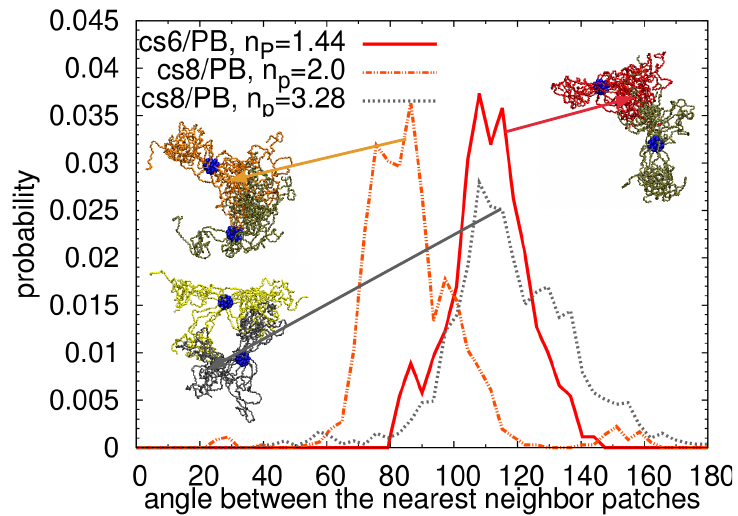
Figure 11. The probability distribution function of the intermolecular angles between the nearest neighbor patches for the star with the lowest number of patches in cs6/PB system (red line) and for the star with the lowest and the highest number of patches in cs8/PB system (orange and dark grey lines, respectively). The average number of patches per star corresponding to each star can be found in the legend. The arrows with the identical colors as the curves point to the characteristic snapshot of the link